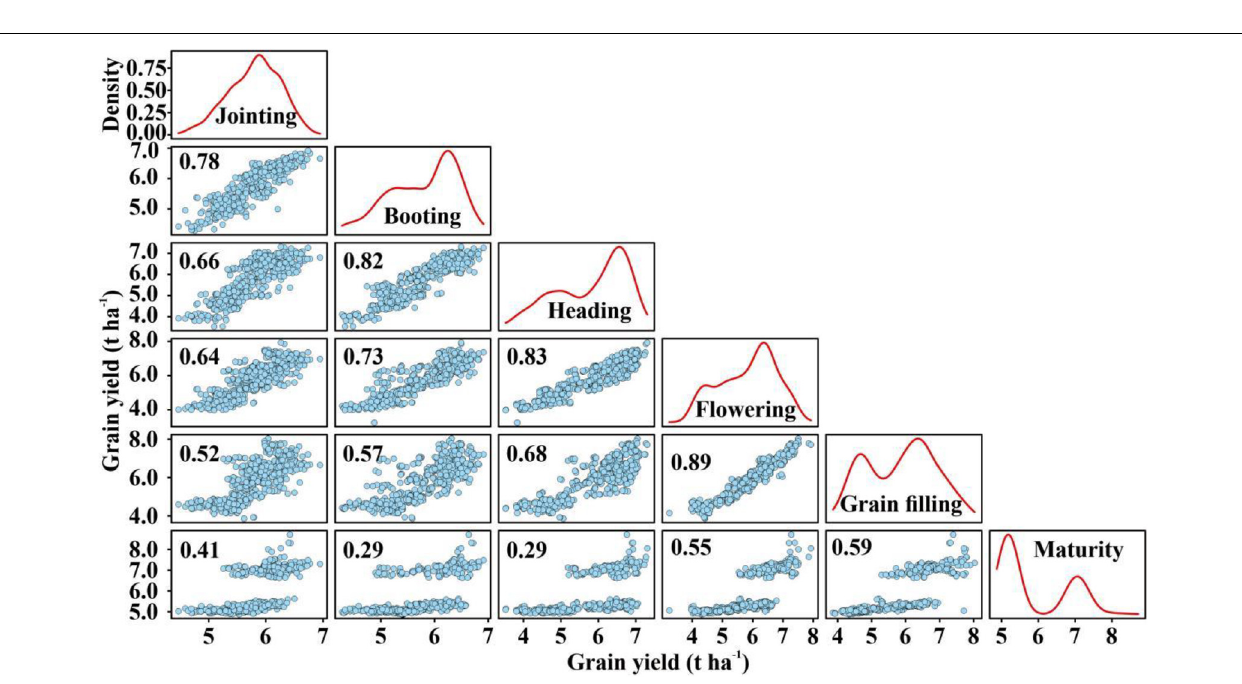
Frontiers in Plant Science |